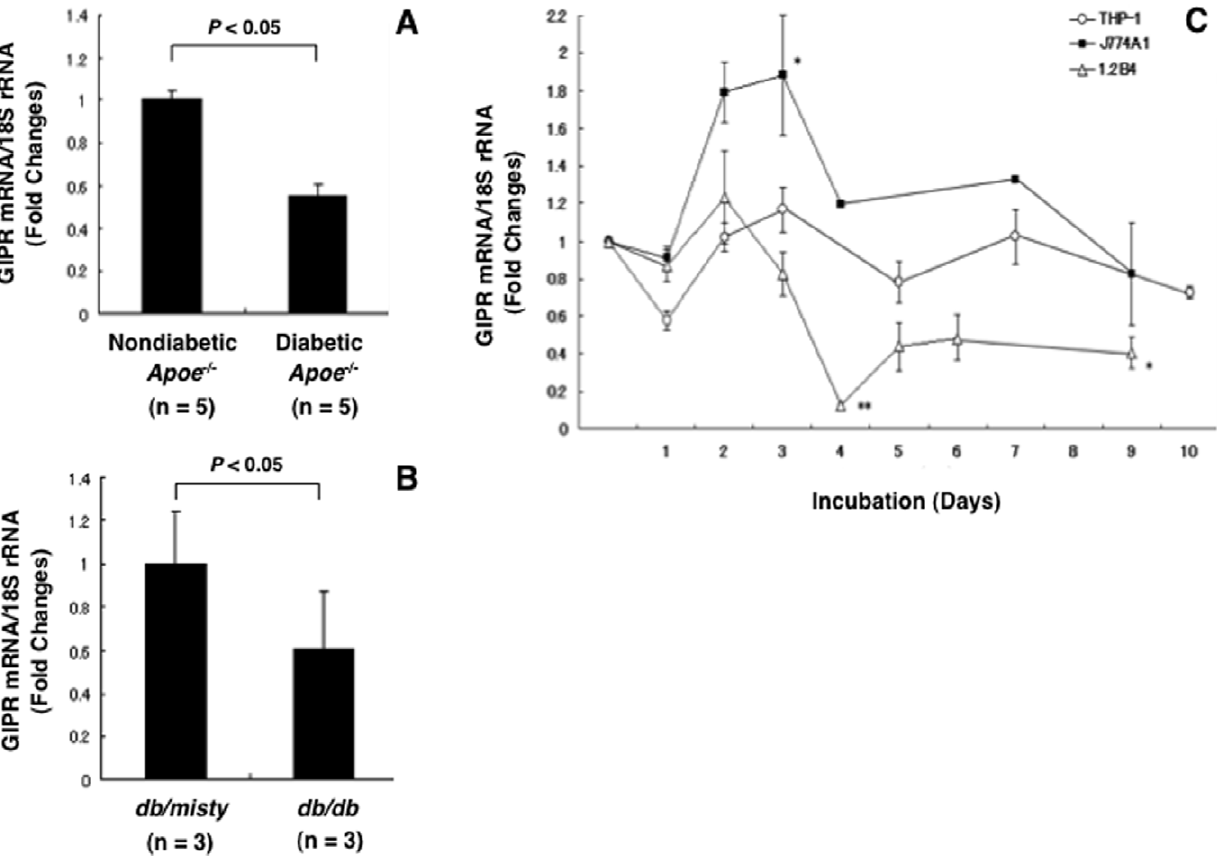
Figure 3. Changes in GIPR mRNA levels in macrophages and pancreatic b -cells exvivo and invitro . A , Exudate peritoneal macrophages were obtained from 5 nondiabetic mice and 5 STZ-induced diabetic Apoe 2 / 2 mice by intraperitoneal injection of thioglycolate. B , Exudate peritoneal macrophages were obtained from 3 db/misty mice and 3 db/db mice at 12 weeks of age. C , THP-1 macrophages (human), J774A1 macrophages (mouse), and 1.2B4 pancreatic b -cells (human) were incubated with RPMI-1640 containing high glucose (500 mg/dl) for 9–10 days. Changes in GIPR mRNA levels were determined by real-time RT-PCR. Three independent experiments were performed. * P , 0.05, ** P , 0.01 vs. each baseline of day 0.